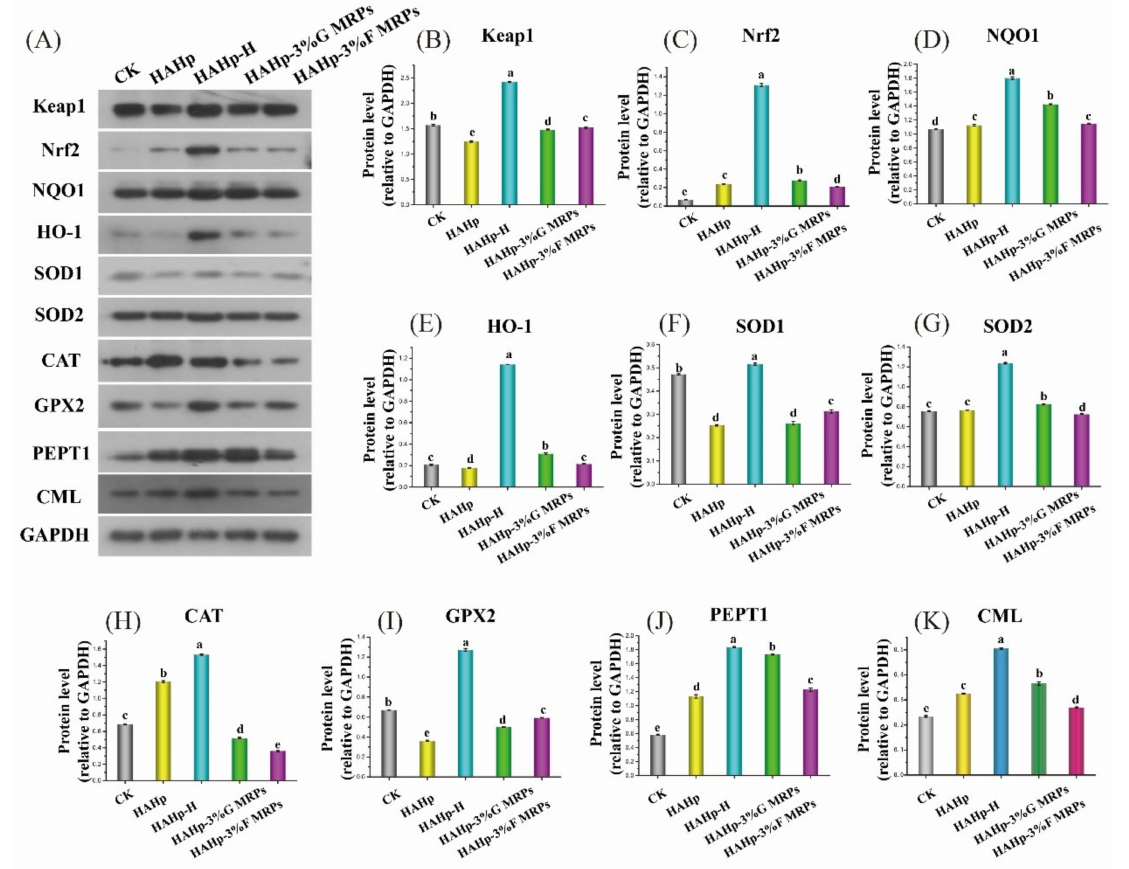
Figure 6. Effects of HAHp, HAHp-H, HAHp-3%G MRP, and HAHp-3%F MRP treatments on the expression of Keap1, transcription factors Nrf2, associated protective phase-II enzymes of NQO- 1 and HO-1, related antioxidant enzymes (SOD1, SOD2, CAT, GPX2), PEPT1, and CML proteins relative to the glyceraldehyde-3-phosphate dehydrogenase (GAPDH) in the colonic mucosas of mice measured via western blot (WB) analysis after 30 days administration compared to the CK. ( A ) WB bands, ( B ) Keap1 protein level, ( C ) Nrf2 protein level, ( D ) NQO-1 protein level, ( E ) HO-1 protein level, ( F ) SOD1 protein level, ( G ) SOD2 protein level, ( H ) CAT protein level, ( I ) GPX2 protein level, ( J ) PEPT1 protein level, and ( K ) CML level. In ( B – K ), data were presented as the mean ± standard deviation ( n = 3). Different lowercase letters (a–e) represent significant difference ( p < 0.05). It is noted that the relative protein expressions of SOD1, CAT, and GPX2 were